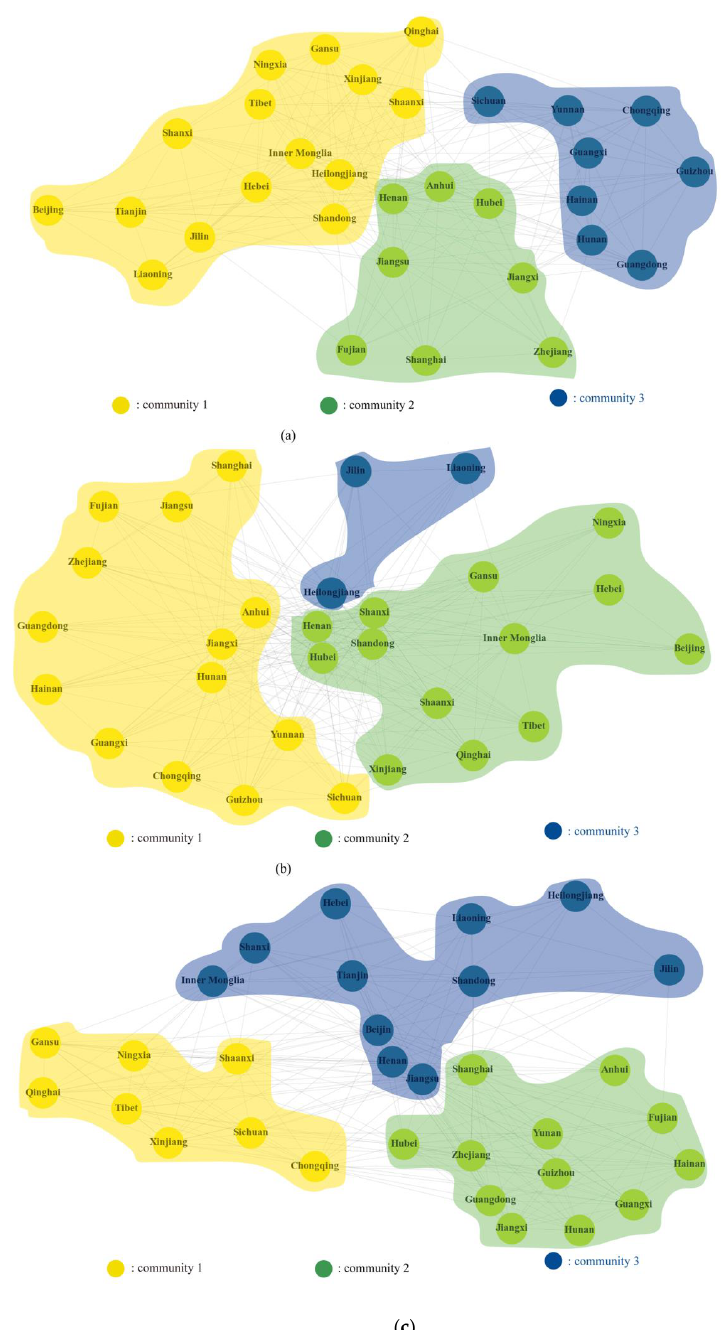
Figure 9. Community distribution of three single-layer networks. ( a ) Community distribution in grain layer; ( b ) Community distribution in disaster layer; ( c ) Community distribution in economy layer. (The three single-layer networks of grain, disaster, and economy are divided into three communities with different colors respectively, and the black solid line represents the association relationship between nodes in the